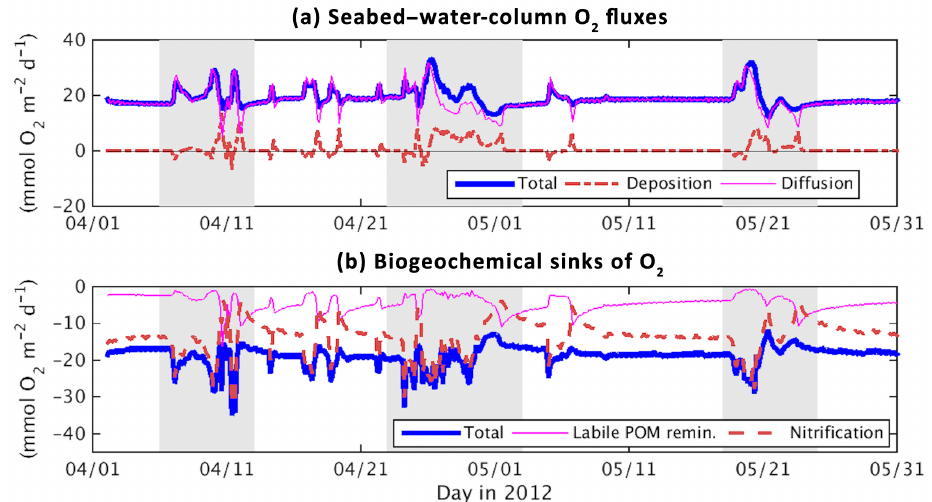
Figure 6. Physical (top) and biogeochemical (bottom) sources and sinks of oxygen within the seabed for the standard model run. Sources and sinks of oxygen to the seabed are positive and negative, respectively. Small biogeochemical sinks <1mmol O 2 m − 2 d − 1 (ODU oxidation and remineralization of refractory POM) are not shown. Shading indicates resuspension events, i.e., cycles of erosion & deposition, including 6–13 April, 23 April–3 May, and 18–25 May